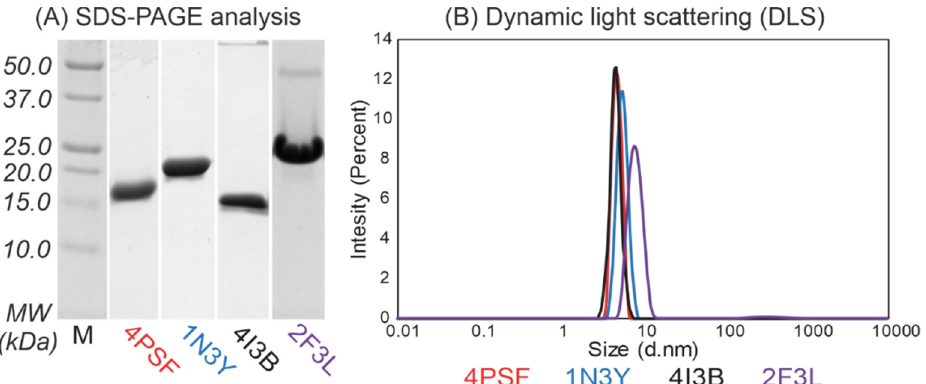
Figure 2. ( A ) Sodium dodecyl sulphate–polyacrylamide gel electrophoresis (SDS-PAGE, 15%) analysis and ( B ) dynamic light scattering (DLS) measurement of the purified protein scaffold candidates with N-terminal His-tags after size exclusion chromatography. The 4PSF, 1N3Y, and 4I3B proteins were isolated to high-purity as monomeric proteins. On the contrary, 2F3L showed minor contaminations around 45 kDa on SDS-PAGE gel and DLS measurement confirmed the presence of bigger particles.